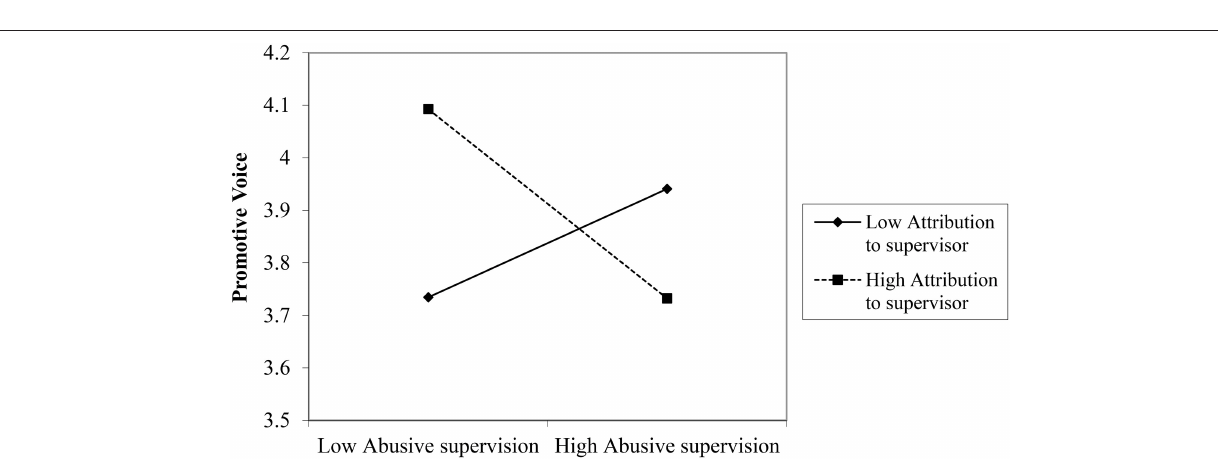
FIGURE 10 | Interaction between abusive supervision and attribution to the supervisor on promotive